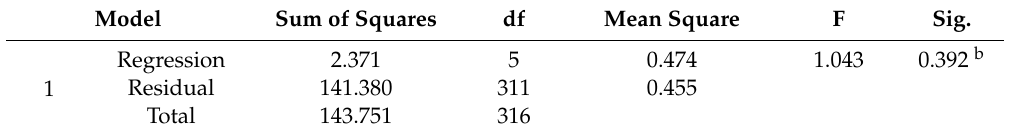
Table 4. ANOVA a